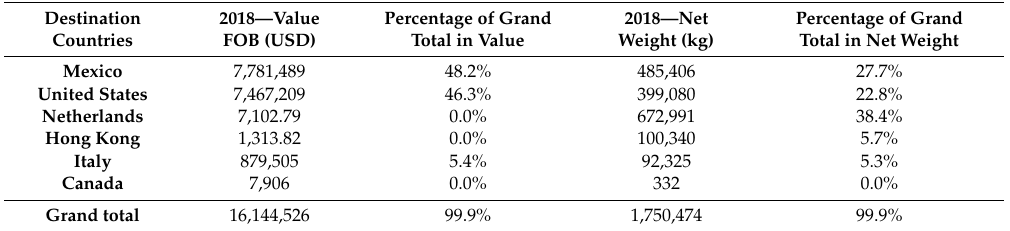
Table 2. Exports of finished leather (HS 4107) from the state of Mato Grosso in 2018, in Free on Board (FOB) value (USD), net weight in kg and percentages relative to the grand total